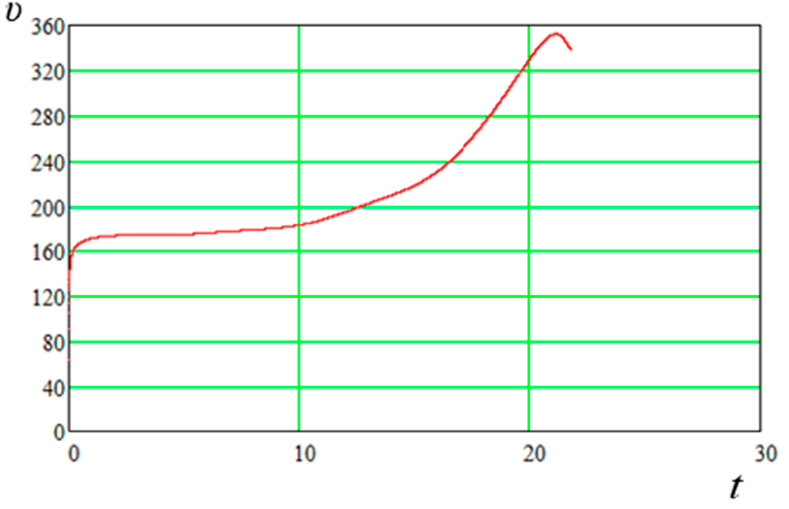
Figure 12. True anomaly [deg.] as a function of flight time [undim.].